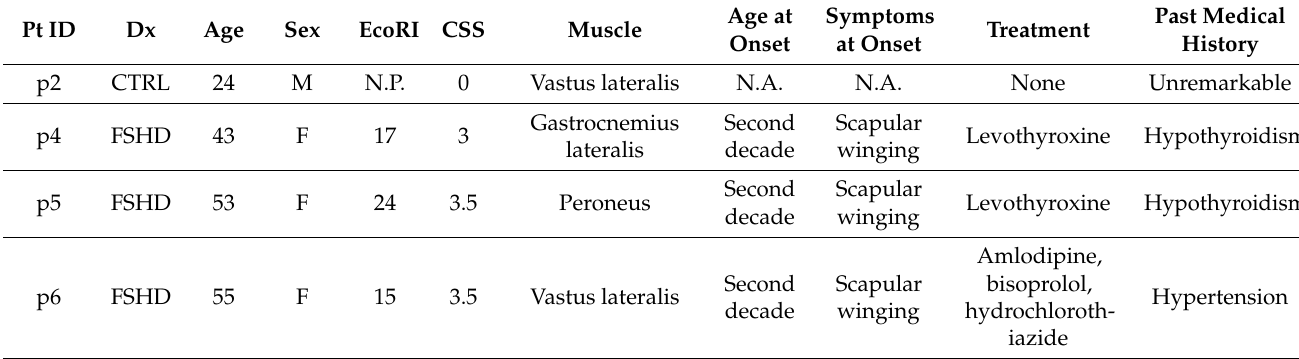
Table 4. Summary of clinical and genetic